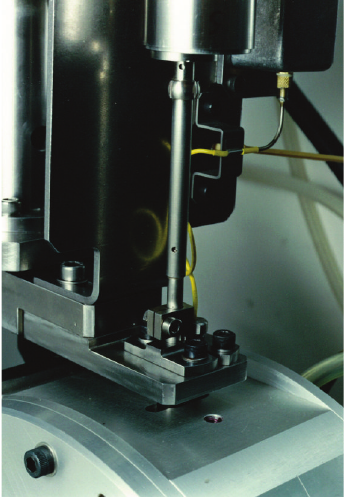
Figure 8: Close-up view of the traverse actuator mounting on the spinning rig housing showing the clamping arrangement of the FM capacitance probe and touch